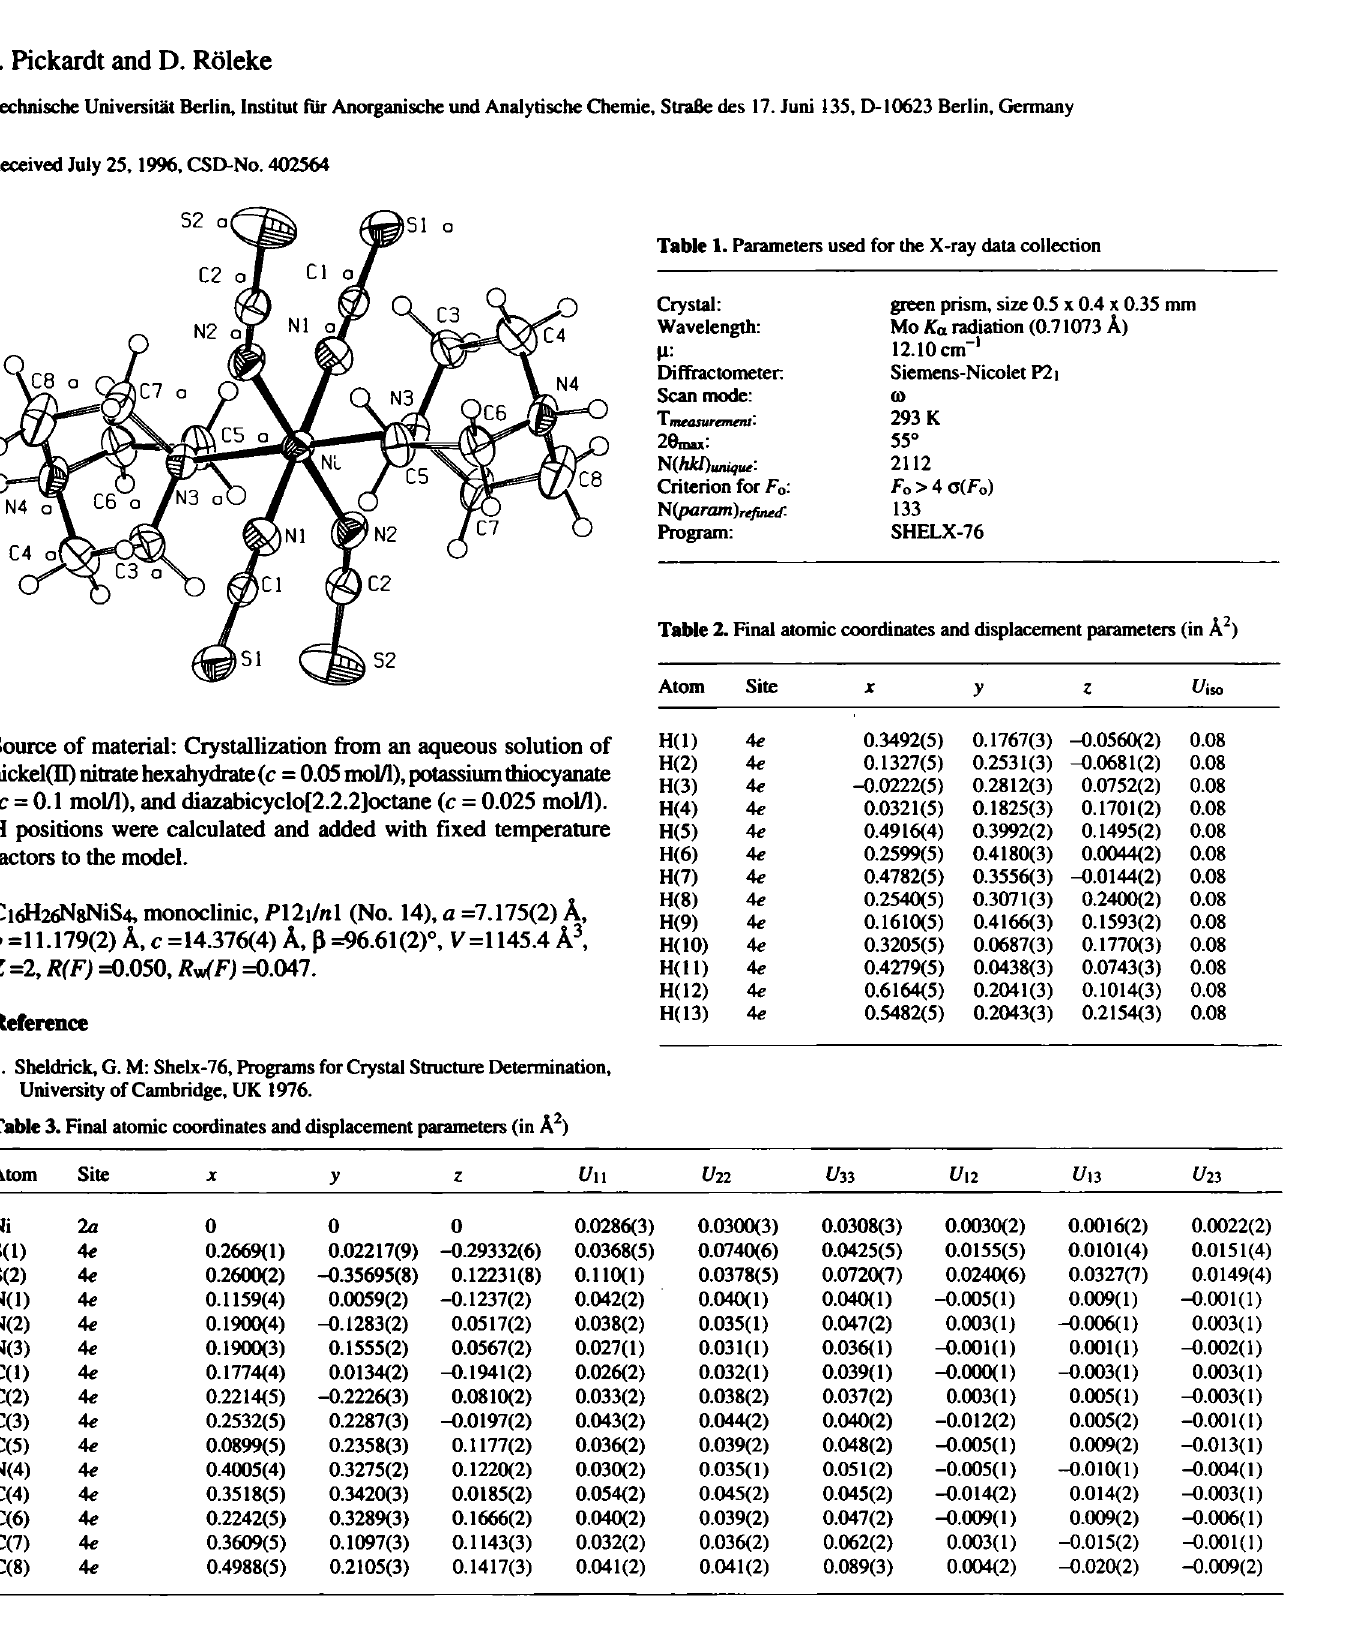
Table 1. Parameters used for the X-ray data collection